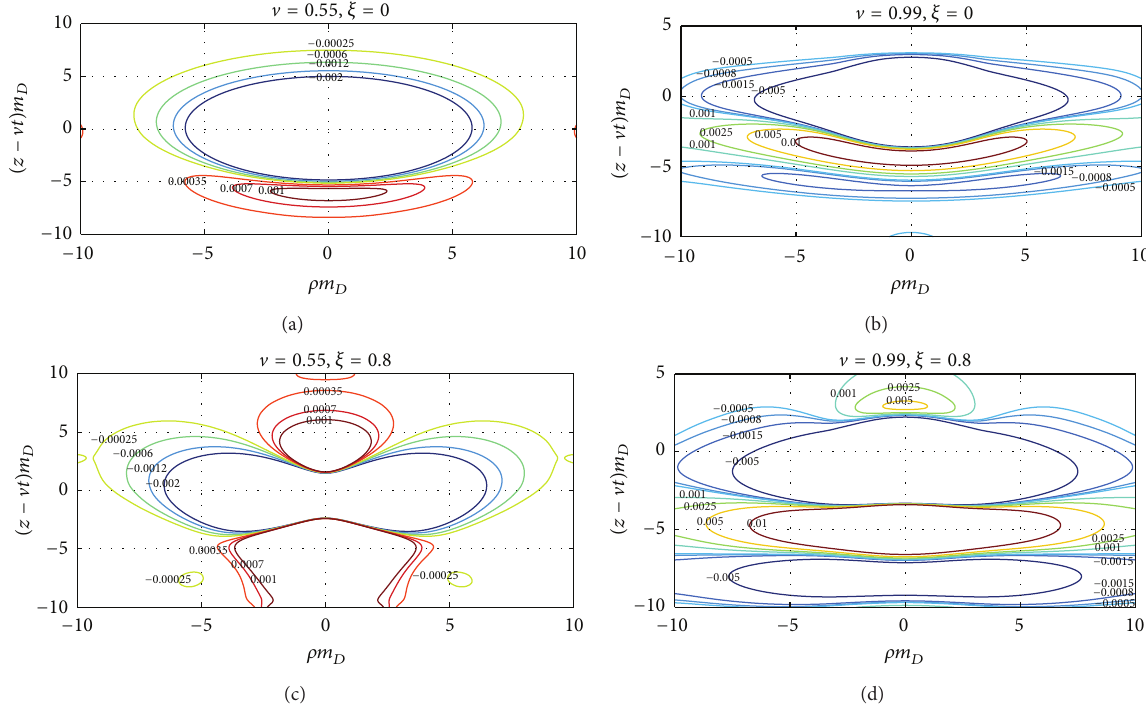
Figure 10: (Color online) Left Panel: the plot shows equicharge line with parton velocity V = 0.55 for different 𝜉(0,0.8) . Right Panel: same as left panel with parton velocity V = 0.99